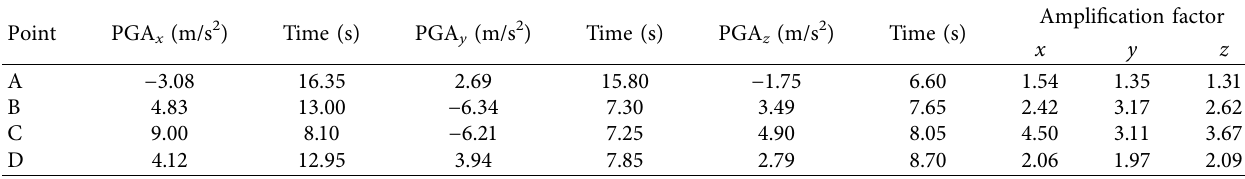
Table 5: PGA amplifcation factor.